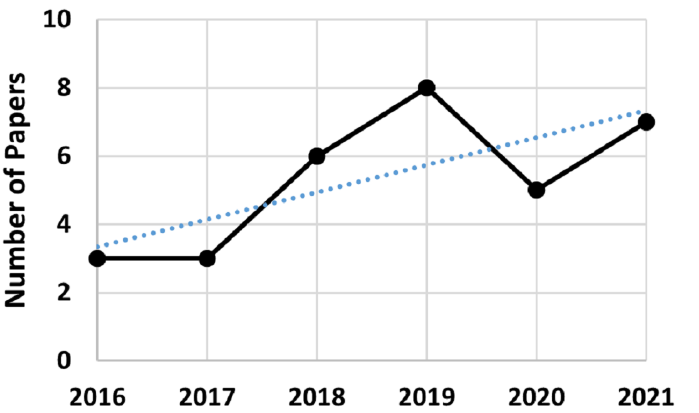
Figure 13. Publication venues’ citation correlation.